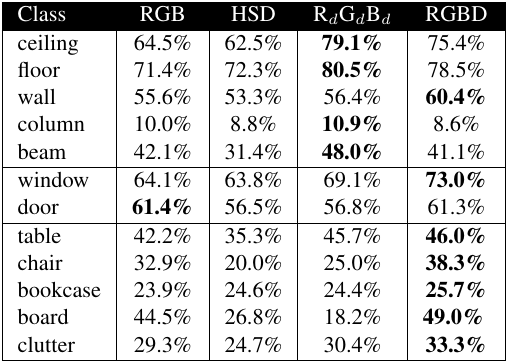
Table 7. IoU per class in test T2 (10% of the dataset for training and 90% for